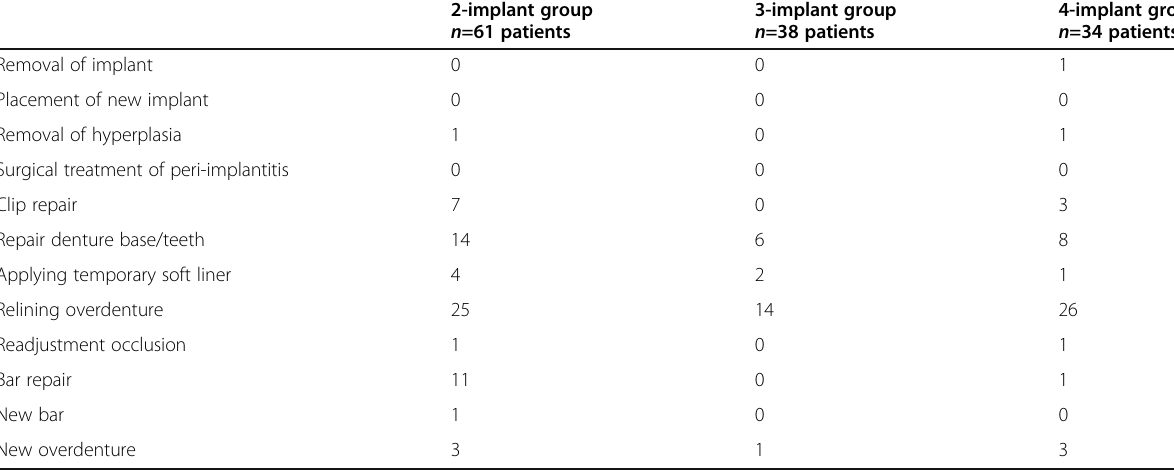
Table 4 Surgical and prosthetic aftercare (number of events) during follow-up